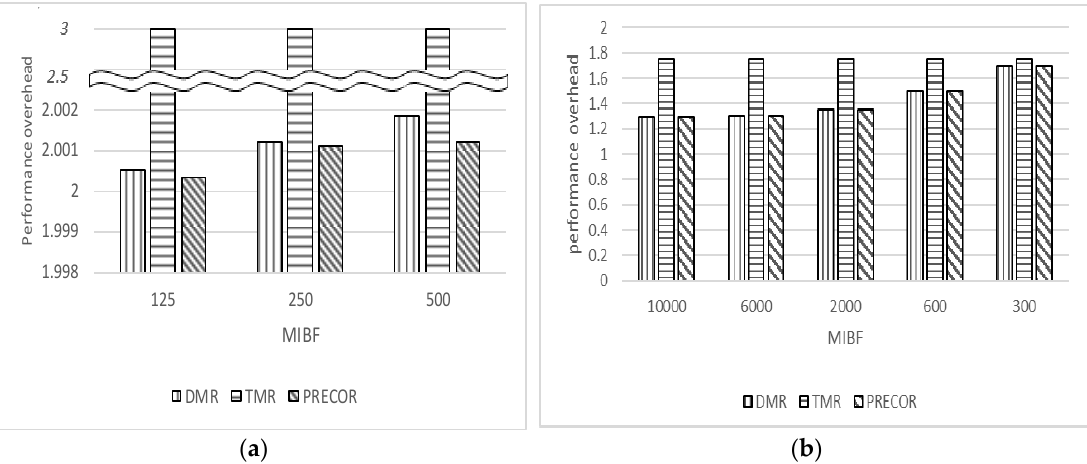
Figure 9. Performance overhead of Dual Modular Redundancy (DMR), TMR and PRECOR: ( a ) hash benchmark; ( b ) breadth first search benchmark.